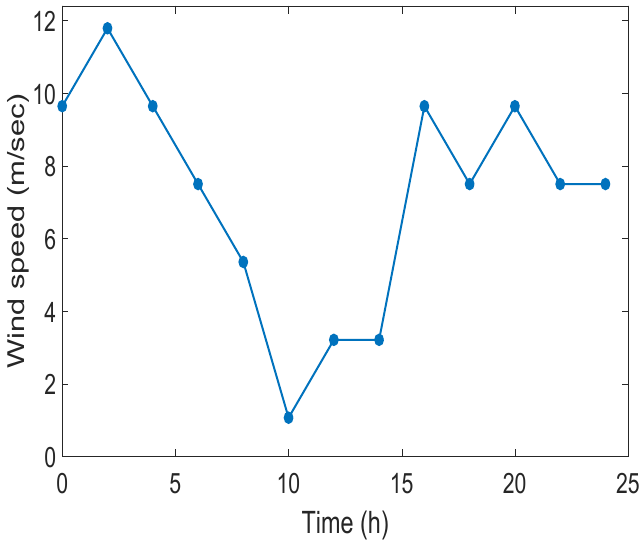
Figure 2. Hourly wind speed curve.